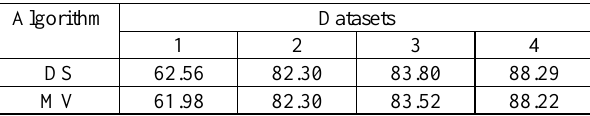
Table 5. Classification accuracy by applying DS and MV algorithm for classifier